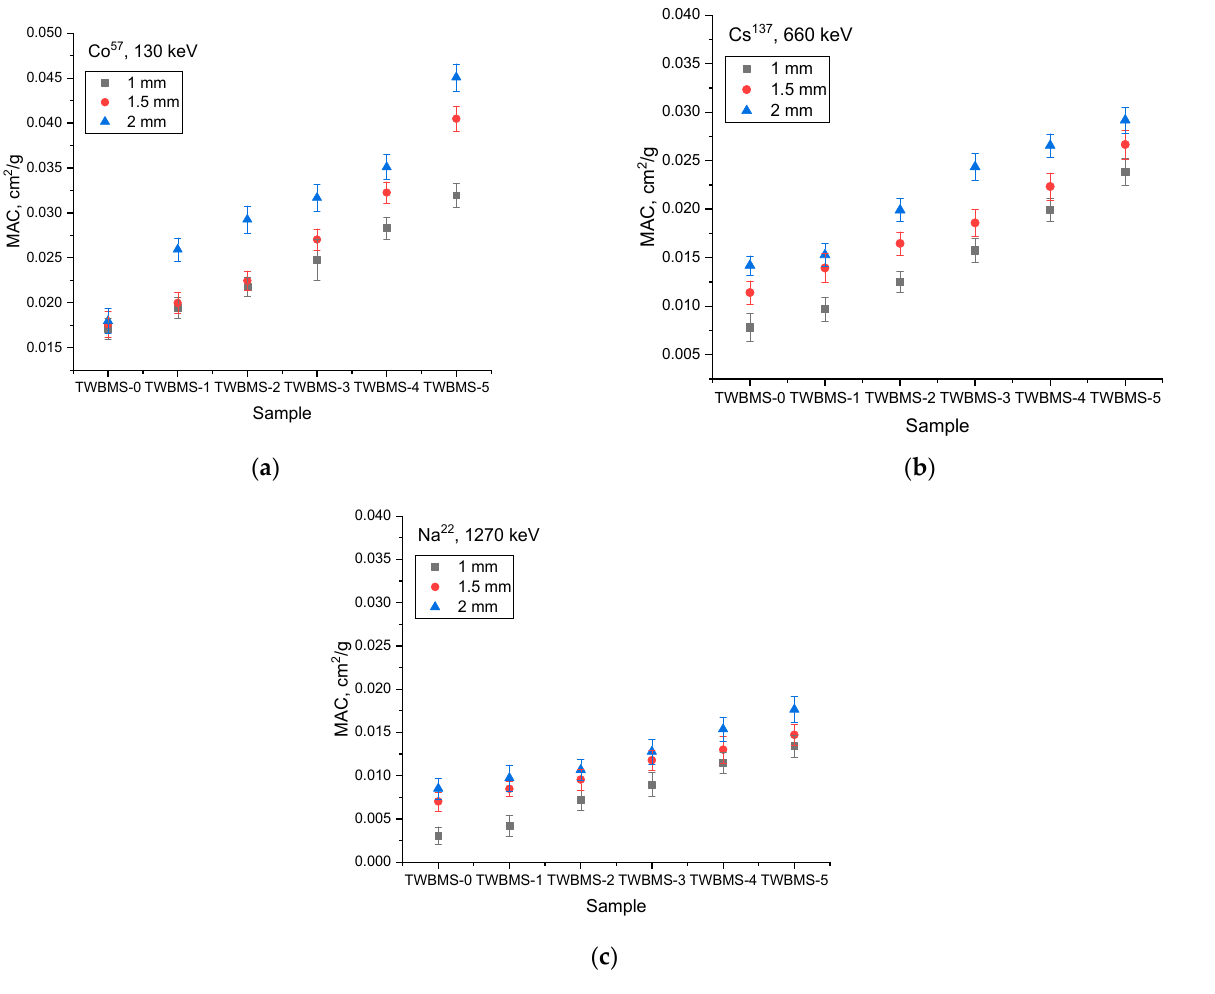
Figure 4. Results of evaluation of the change in the linear attenuation coefficient of gamma radiation depending on the type of gamma-quantum source: ( a ) Co 57 , 130 keV; ( b ) Cs 137 , 660 keV; ( c ) Na 22 , 1270 keV.